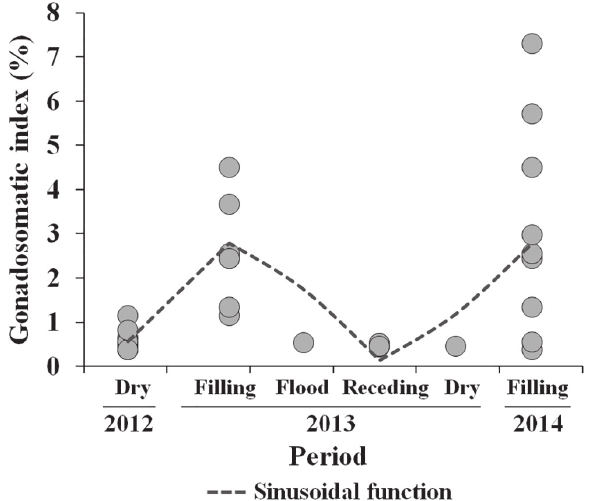
Fig. 4. Variation of the gonadosomatic index (GSI) of adult (reproductive) red-tailed catfish Phractocephalus hemioliopterus specimens collected from the Xingu River, in Pará,